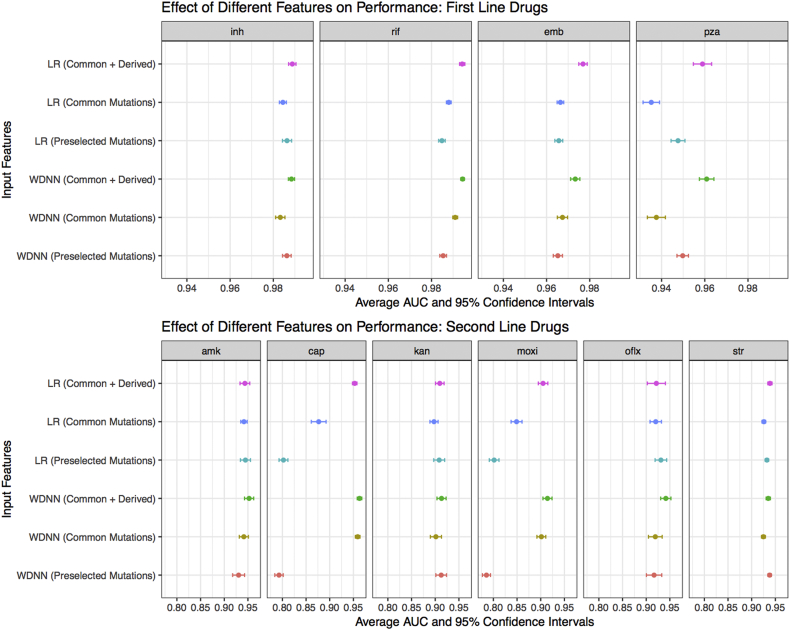
Comparison of tuberculosis drug resistance predictive performance based on input feature set. Area under the ROC curve classification performance and 95% confidence intervals during repeated cross-validation for the MD-WDNN and logistic regression models trained on all features (common and derived mutations), MD-WDNN trained on just mutations (Common Mutations), and the trained on mutations and derived categories occurring in genes known to be resistant determinants for each drug (Preselected Mutations).